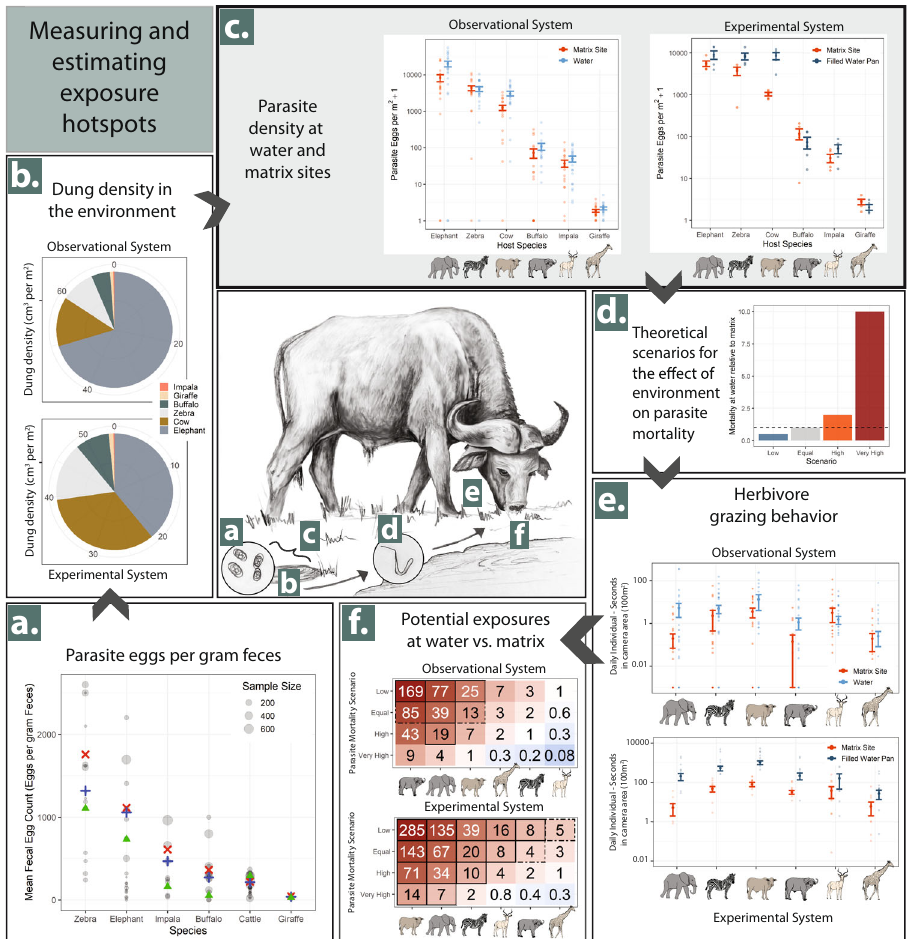
Fig. 2 Measurements of parameters used to calculate parasite density in the environment and to estimate the degree to which potential parasite exposures are elevated near water relative to matrix sites. a – f Key transmission steps noted in the central fi gure. a Fecal egg counts measured in this study (green triangles) compared to those reported in studies across the African continent (mean of individual studies in blue; studies weighted by sample size in red). b Average dung density contributed by each major species in both experimental (OPC) and observational systems (Mpala). c Comparisons of estimated parasite eggs contributed by each species at permanent water sources (either dams or pans, shown in blue) and matrix sites (calculated from both experimental and observational data sets, shown in orange) show considerable consistency across species. Estimates from the experimental system compare fi lled pans only to matrix sites. Note that both graphs are visualized on the log 10 scale. Bars and centers represent means ± SE calculated from parasite density at the site level, averaged across all periods (observational system: n = 20 per species and treatment, experimental system: n = 5 per species and treatment). d Four theoretical scenarios of parasite mortality at water sources relative to matrix sites, ranging from an assumption of reduced mortality (low; in blue) due to potential increases in ground moisture, to an assumption of greatly increased mortality (very high; in red) due to decreases in vegetation cover. e Herbivore grazing activity at water sources (in blue) and matrix sites (in orange) for both experimental and observational systems. Note that both graphs are visualized on the log 10 scale. Bars and centers represent means ± SE calculated from average daily grazing activity at the site level, averaged across all periods (observational system: n = 12 per species and treatment, experimental system: n = 5 per species and treatment). f Relative number of potential parasite exposures at water relative to matrix sites for each species and parasite mortality scenario from d . Signi fi cant ( p < 0.05) and marginally signi fi cant ( p < 0.1) differences for two-sided t -tests with Holm adjus t ment for multiple comparisons are bordered by solid and dotted lines respectively. Source data are provided as a Source Data fi le. Centre panel and icon artwork by G.